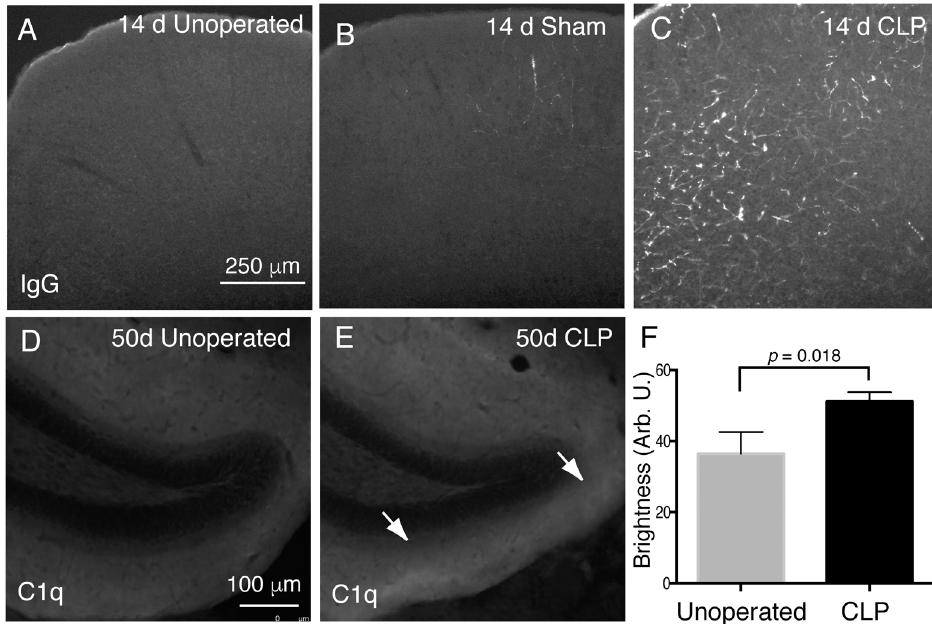
Fig 3. IgG and C1q deposition in the brain after CLP. Immunofluorescent staining for total mouse IgG does not reveal any tissue deposition in unoperated mice (A). In sham operated mice, there are sparse, focal areas of IgG immunoreactivity (B). After CLP, large areas of IgG immunoreactivity are present in a perivascular pattern (C). There is increased immunoreactivity for complement component C1q in the dentate gyrus in after CLP (arrows, E) compared to unoperated control mice (D, F).